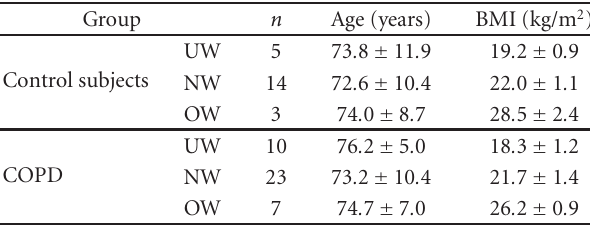
Table 1: Baseline characteristics of subjects.